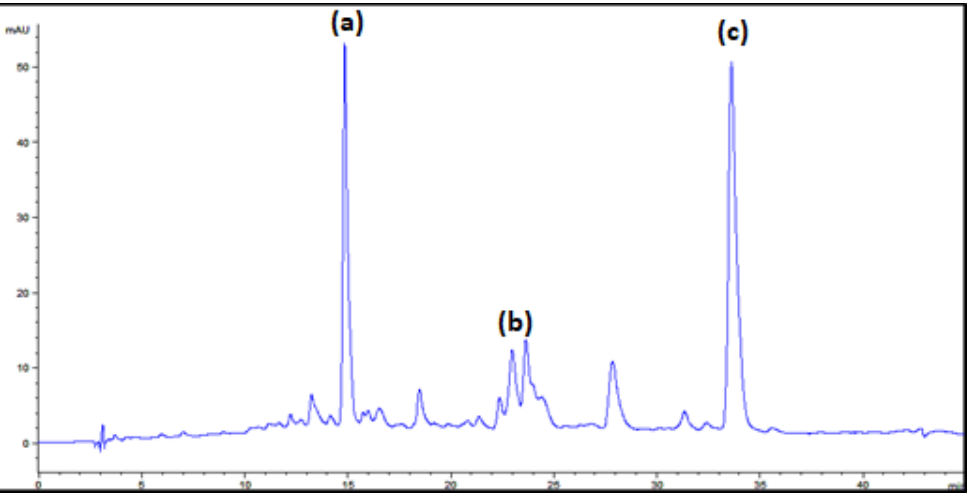
Figure 2. Carotenoid profile from Rhodotorula glutinis P4M422 cultivated in goat milk whey: (a) β –carotene, (b) γ –carotene and (c) torulene.